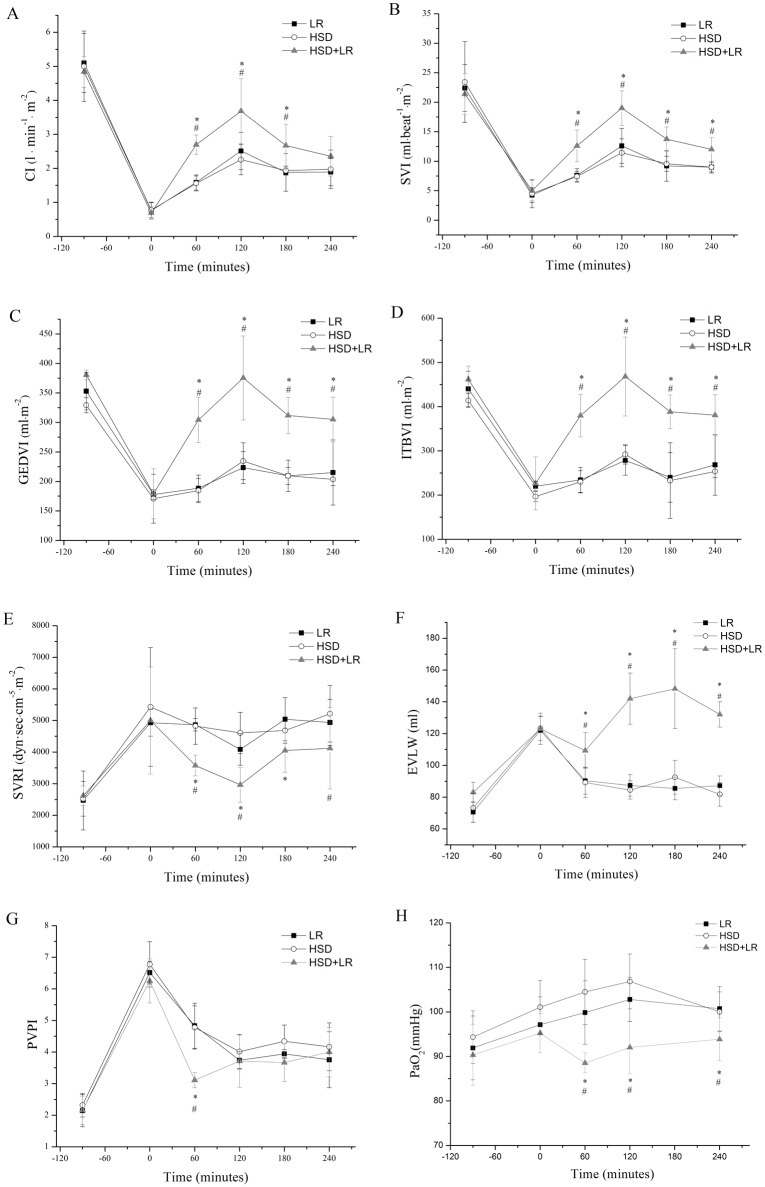
Hemodynamic parameters changes after hemorrhagic shock and resuscitation.Pre-hospital resuscitation (0-60min) from hemorrhagic shock respectively with (1) 40ml/kg lactated ringers at a constant rate of 20 ml/min (LR group), (2) a bolus of HSD (4ml/kg) over a fixed interval of 2 min (HSD group), or (3) an initial bolus of HSD (4ml/kg) with a continued infusion of 40ml/kg Lactated Ringer (HSD+LR group). Subsequently all groups were injected with lactated ringers in in-hospital (60-90min) until the MAP reached 85% of the baseline level. (A) cardiac index (CI). (B) systolic volume index (SVI). (C) global end-diastolic index (GEDVI). (D) total intrathoracic blood index (ITBI). (E) systemic vascular resistance index (SVRI). (F) extravascular lung water (EVLW) (G) pulmonary vascular permeability index (PVPI). (H) arterial oxygen tension (PaO2). *P<0.05 vs LR (black square); #P<0.05 vs HSD (open circle); &P<0.05 vs HSD+LR (shaded triangle). n = 7 for all groups.